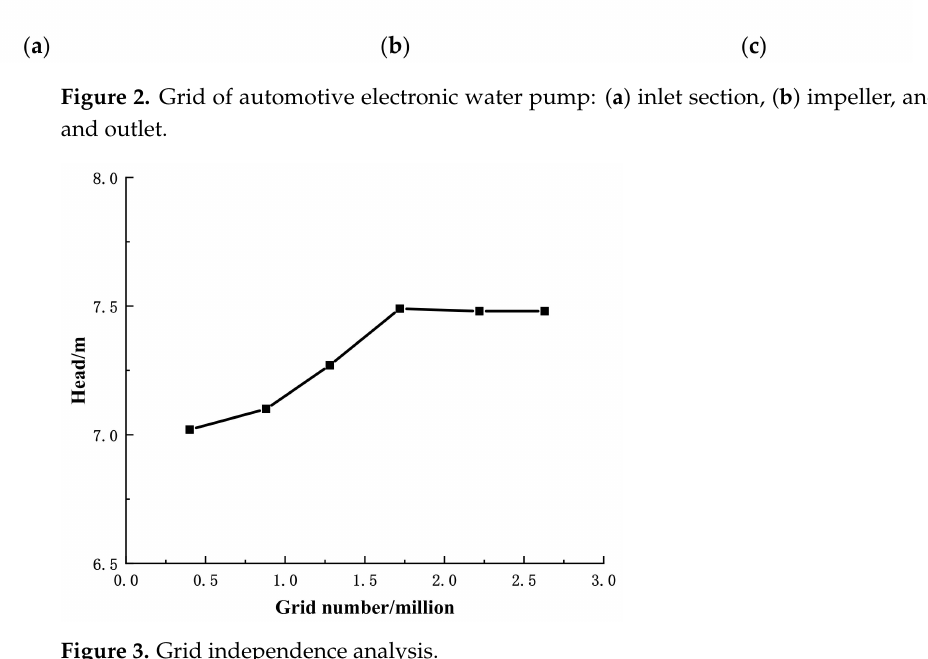
Figure 3. Grid independence analysis. Table 2. Grid information of